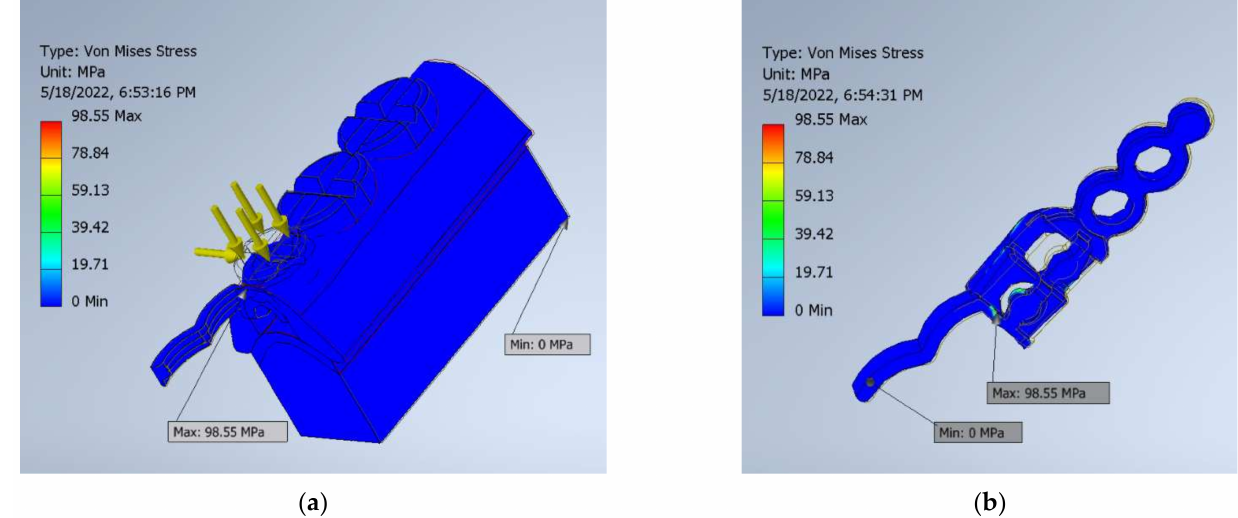
Figure 6. Maximum von Mises stress in unilateral RPD with implant when the forces were applied on the PM2: ( a ) full analyzed assembly; ( b ) metallic